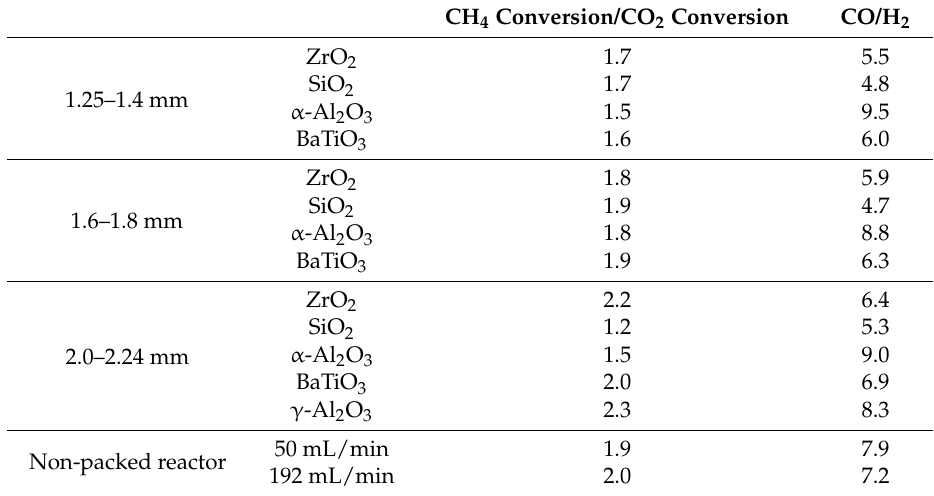
Table 3. Ratio of CH 4 conversion over CO 2 conversion and of the CO over H 2 product fraction, for the different sphere sizes and materials, as well as for the non-packed